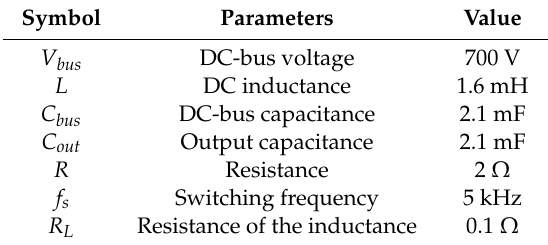
Table 1. Related parameters of the converter.